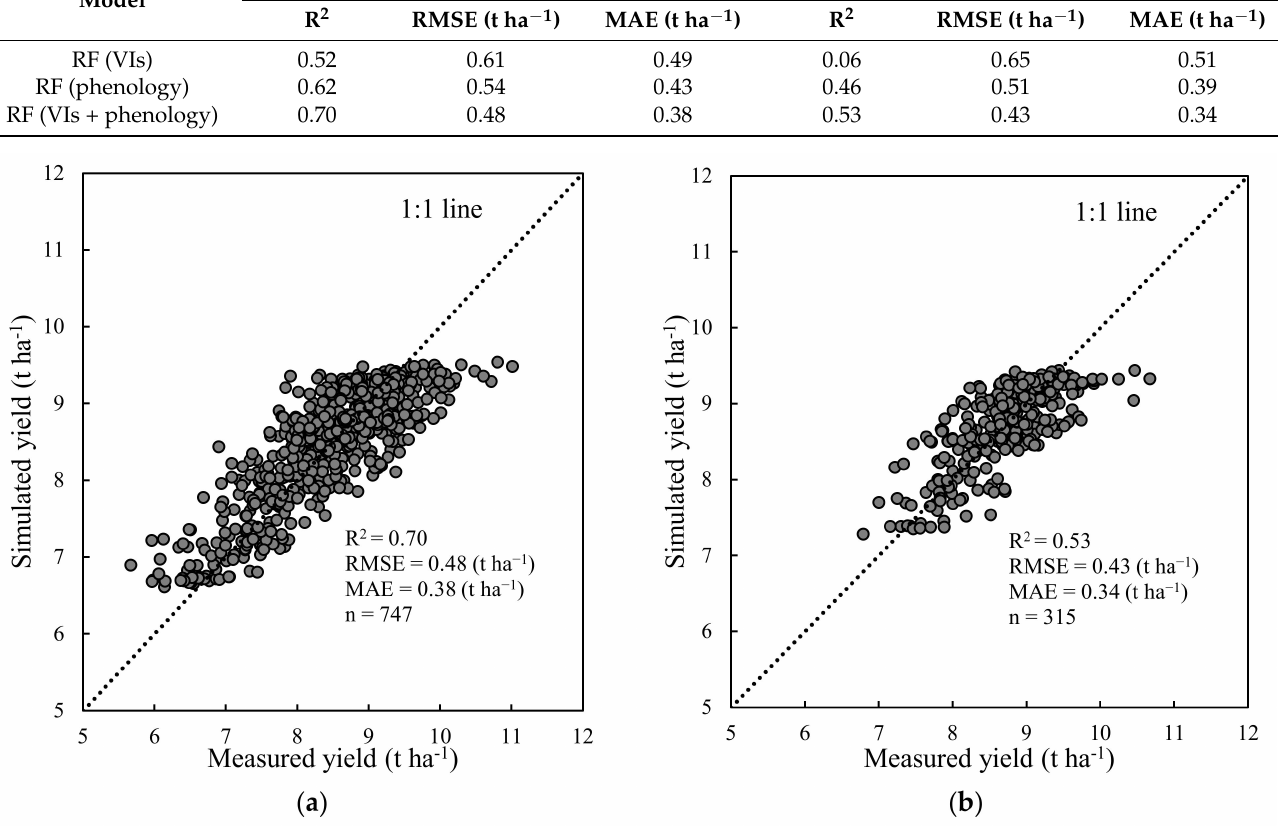
Figure 6. Measured vs. simulated yield from the RF (VIs + phenology) model in calibration set ( a , 747 plots in 2017 and 2018) and validation set ( b , 315 plots in